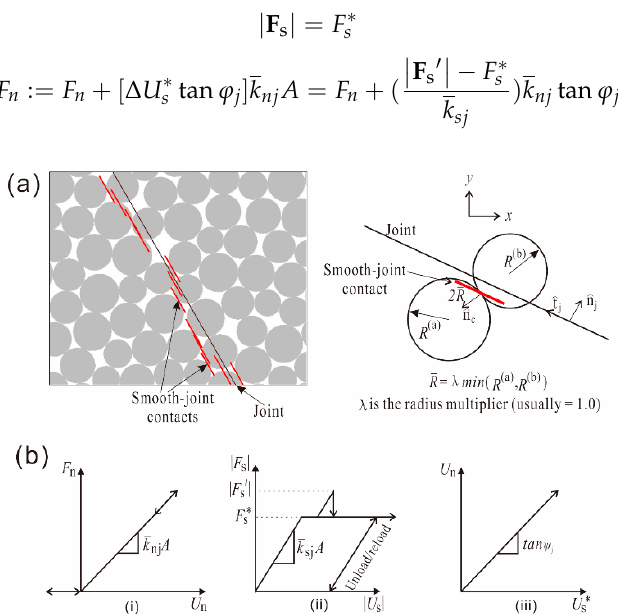
Figure 8. Smooth joint model [49]: ( a ) Sketches of smooth joint model; ( b ) force-displacement relationship at smooth joint contacts: (i) normal force versus normal displacement; (ii) shear force versus shear displacement; and (iii) normal displacement versus shear displacement in the sliding process.